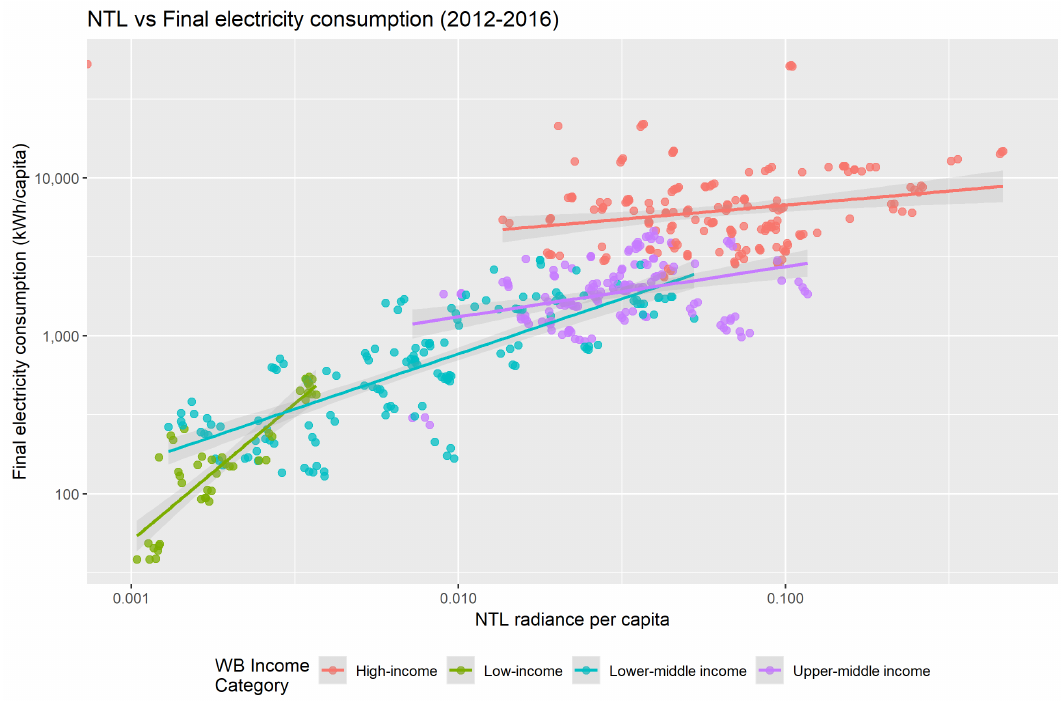
Figure 3. Night-time light (NTL) vs. TFC by World Bank (WB) Income Category (annual values between